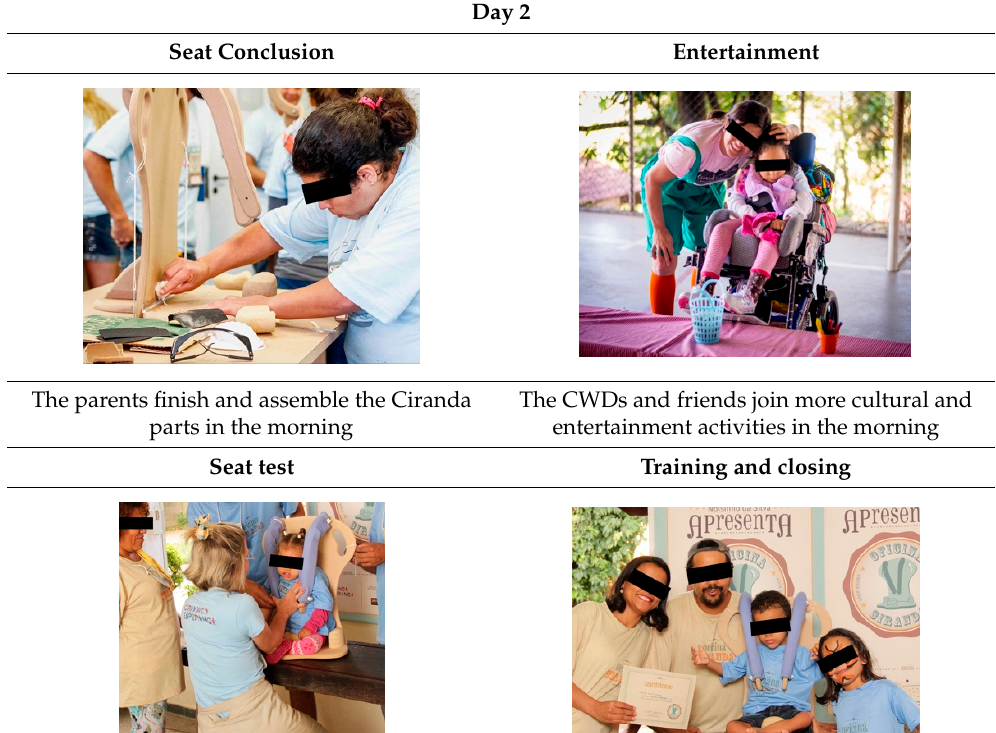
Table 2. The second day of the Ciranda Workshop event.